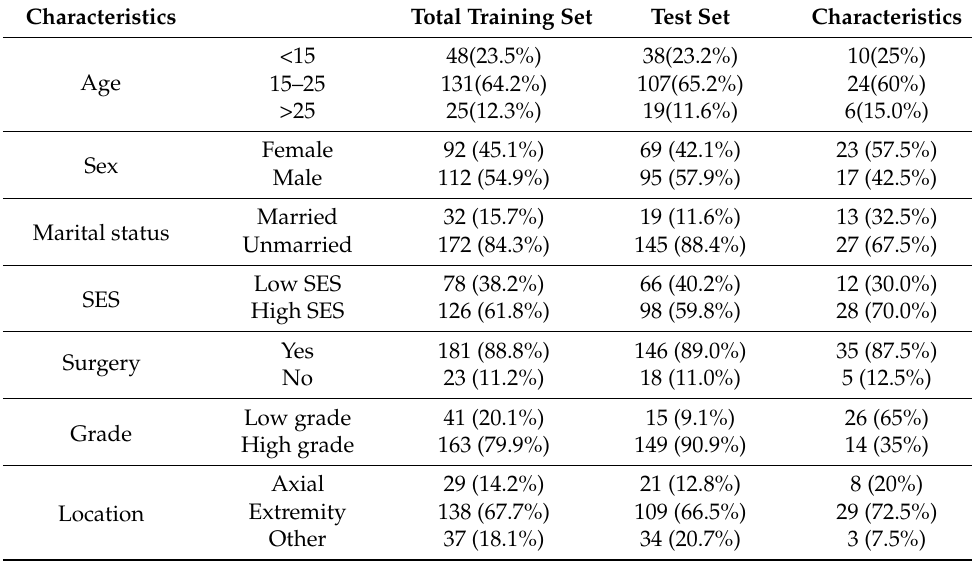
Table 2. Patient information providing experimental data.